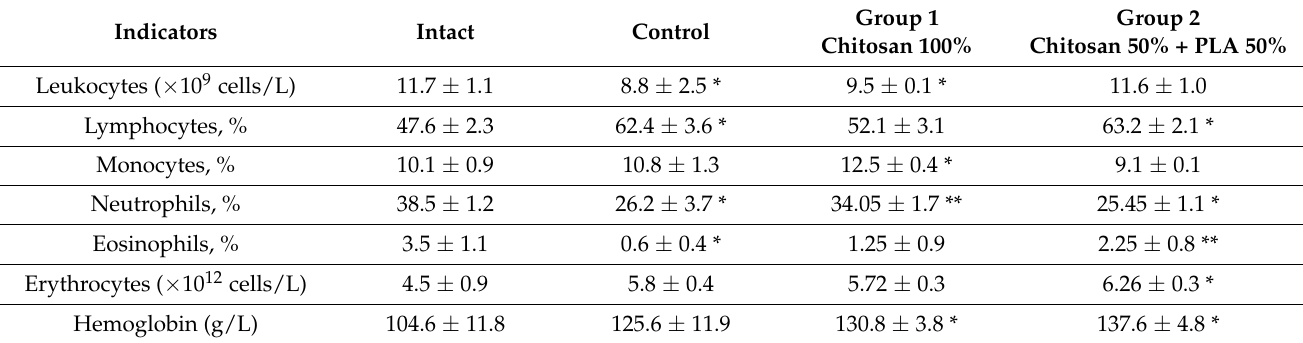
Table 6. Blood parameters of the same rats three weeks after implantation.